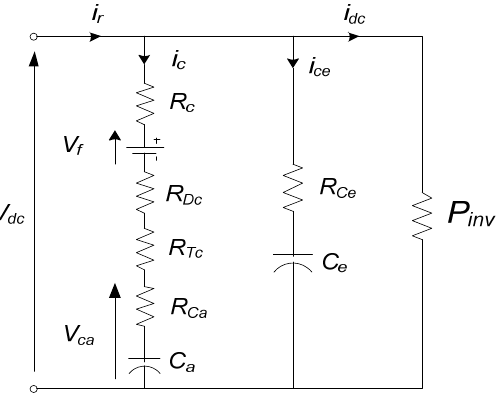
Figure 3. DC-link during